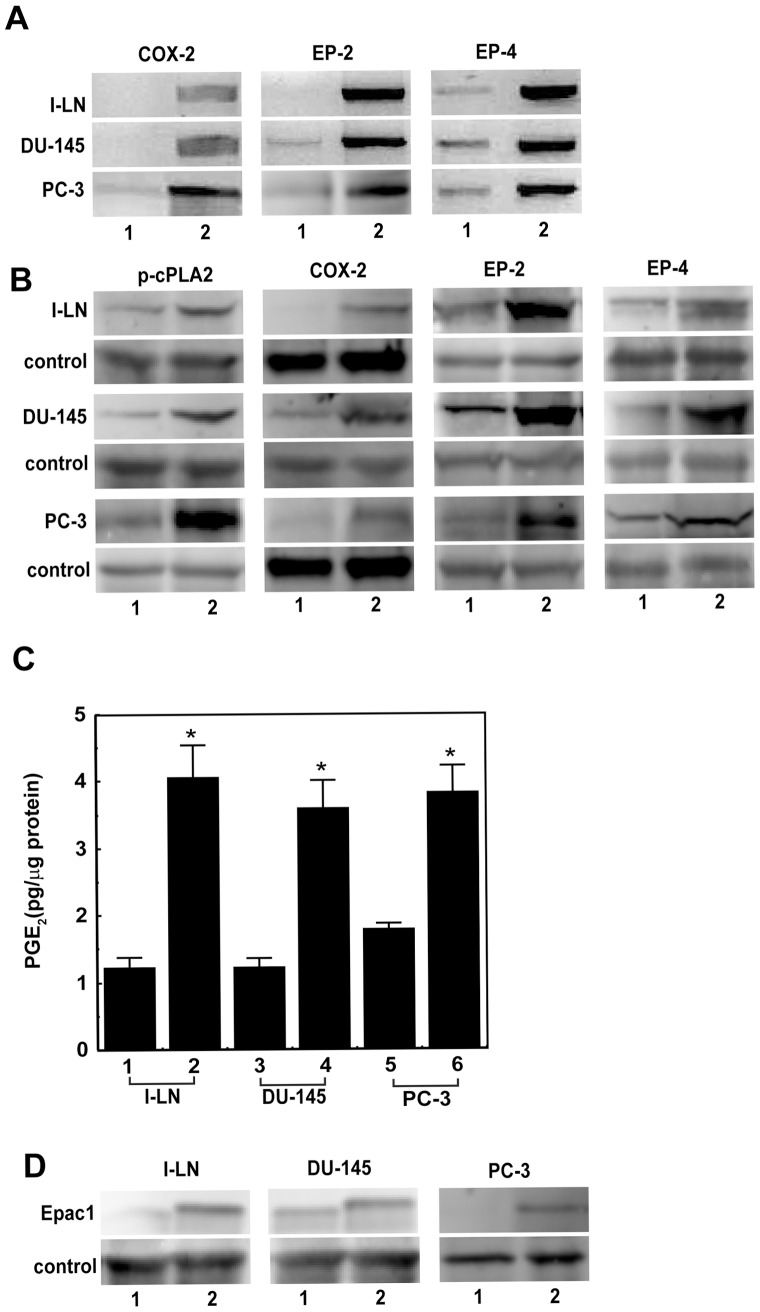
8-CPT-2Me-cAMP-induced expression of inflammation markers in prostate cancer cells.
Panel A. Upregulation of COX-2, and EP2 and EP4 receptor mRNA in 1-LN, DU-145, and PC-3 prostate cancer cells stimulated with 8-CPT-2Me-cAMP (100 μM/30 min). The lanes are (1) buffer stimulated; and, (2) 8-CPT-2Me-cAMP-stimulated. Panel B. Immunoblot showing upregulation of p-cPLA2, COX-2, EP2, and EP4 in prostate cancer cells stimulated with 8-CPT-2Me-cAMP (100 μM/30 min). Panel C. A bar diagram showing 8-CPT-2Me-cAMP-induced upregulation of PGE2 synthesis in prostate cancer cells. Levels of PGE2 are expressed as pg PGE2/μg of cell protein. Values significantly different at 5% levels from buffer and treated cells are marked with an asterisk (*). Panel D. An immunoblot showing Epac1 protein levels in 1-LN and DU-145 and PC-3 prostate cancer cells stimulated with 8-CPT-2Me-cAMP(100 μM/30 min). Lanes in Panel B, C, and D are as in Panel A. All experiments were performed in triplicate and a representative immunoblot and the respective protein loading control actin or the unphosphorylated target proteins cPLA2 and Epac1 is shown.